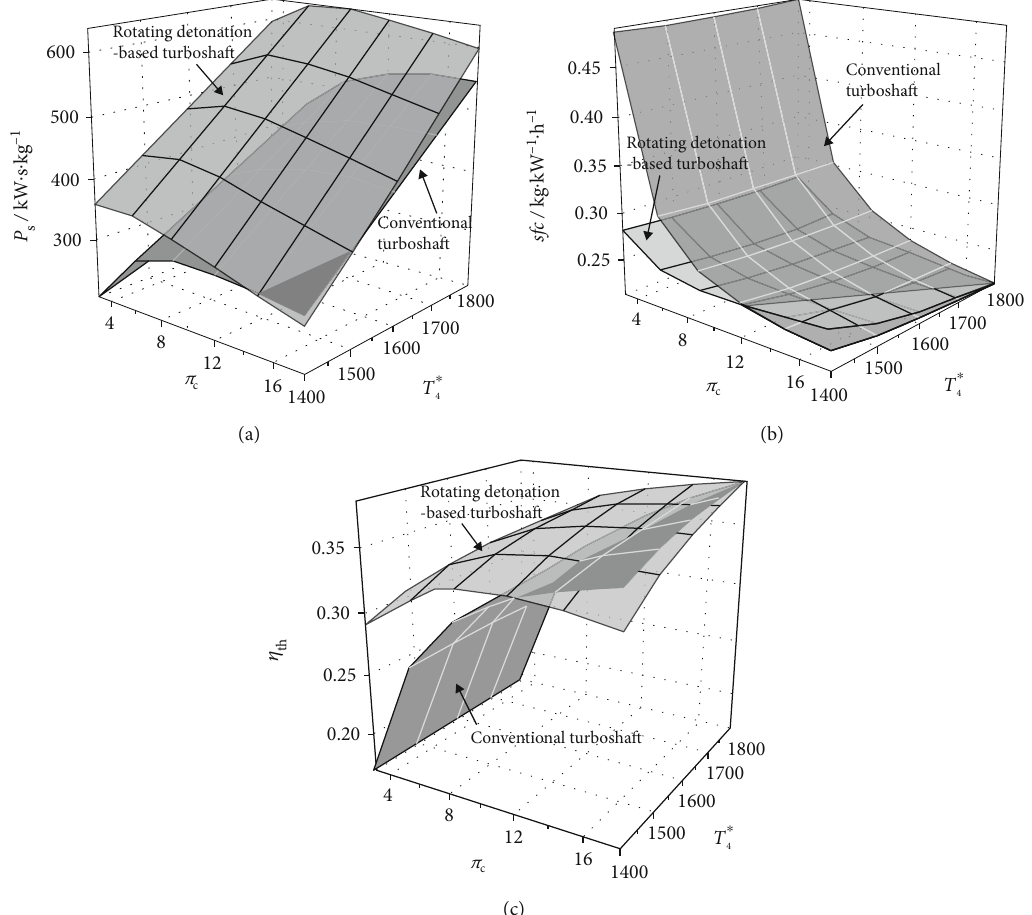
Figure 7: Performance comparison of turboshaft engine based on rotating detonation and the conventional one for di ff erent cycle parameters. (a) P s , (b) sfc , and (c) η th